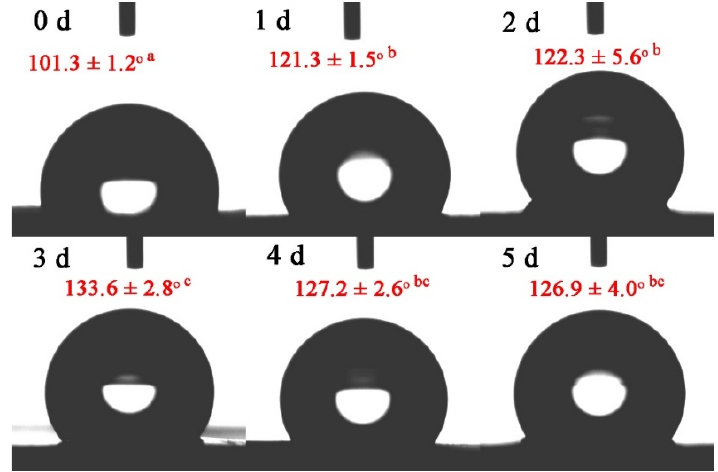
Figure 7. The water contact angles of gelatin/zein/glucose nanofibers after Maillard reactions conducted at 60 °C and 50% RH for 0~5 days. Values with different superscript letters are significantly different ( p < 0.05).